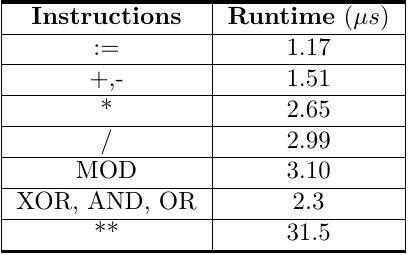
Table 4: Runtimes of Important Atomic Operations on 32-bit DINT Variables Instructions